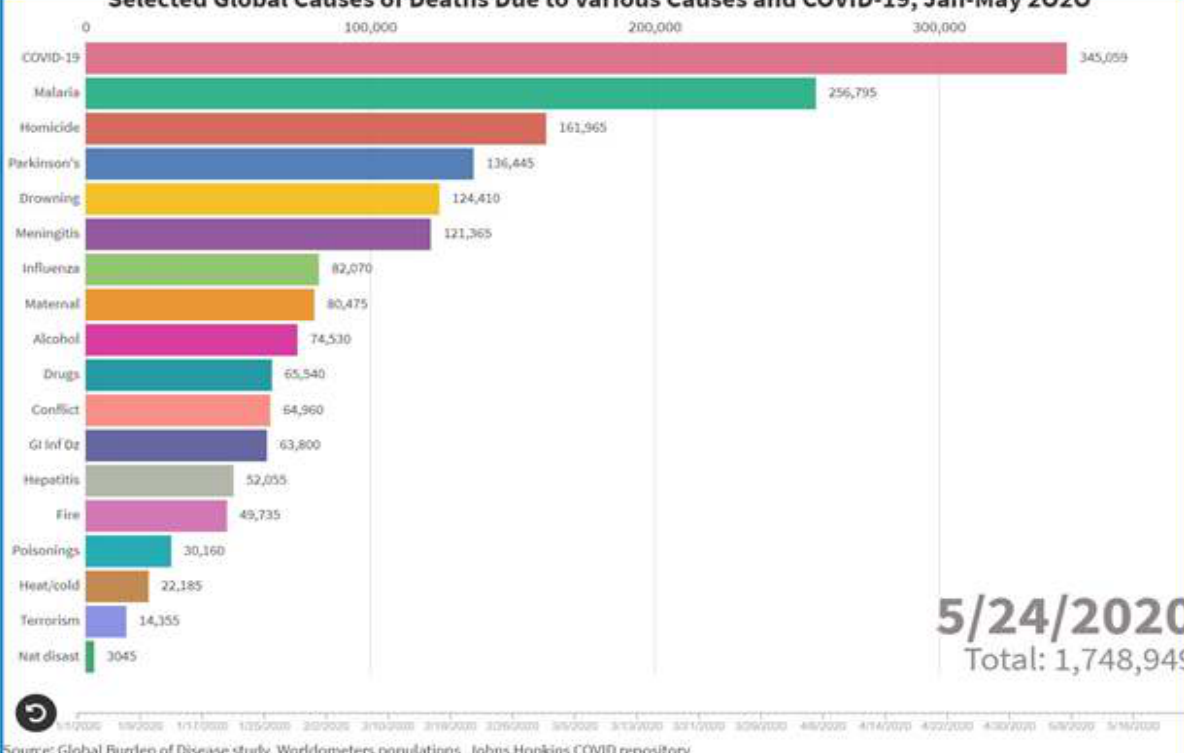
Figure-I: Global Causes of Death.